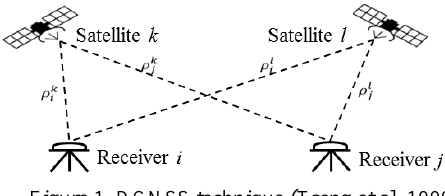
Figure 1. DGNSS technique (Tseng et al. 1999)